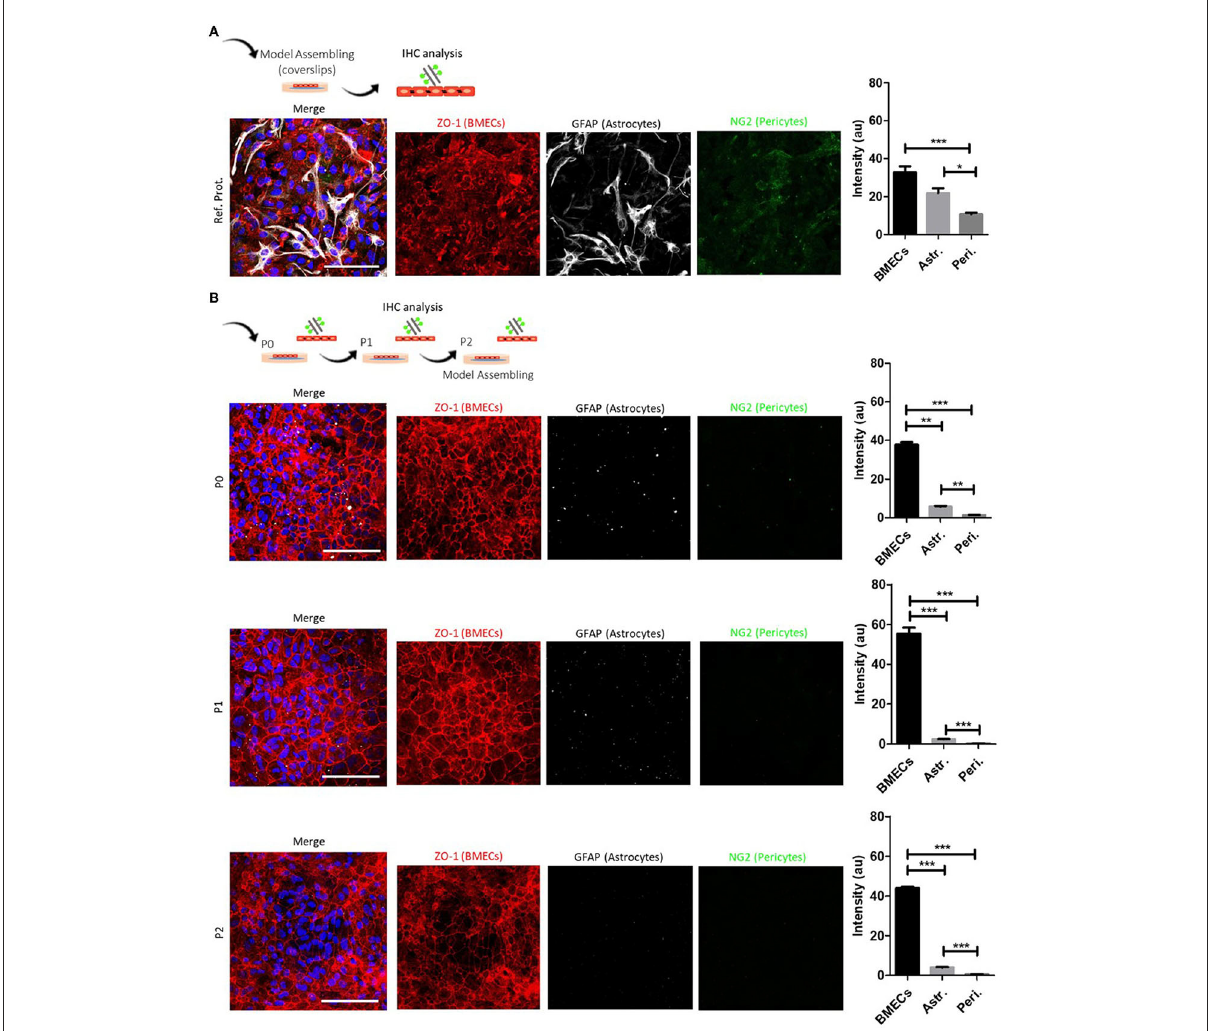
FIGURE2 BMECs primary culture characterization and model assembling in coverslips. (A) Schematic representation of the methodology for the characterization of BMECs primary culture and representative composite confocal images of ZO-1/NG2/GFAP labeling. After reviewing BMECs protocols, we made a first primary culture adapted from our reference protocol (Xue et al., 2013). Quantitative analysis at P1 shows an abundant presence of BMECs (ZO-1) and astrocytes (GFAP). Pericytes (NG2) are found in less proportion. (B) Proposed BMECs primary culture